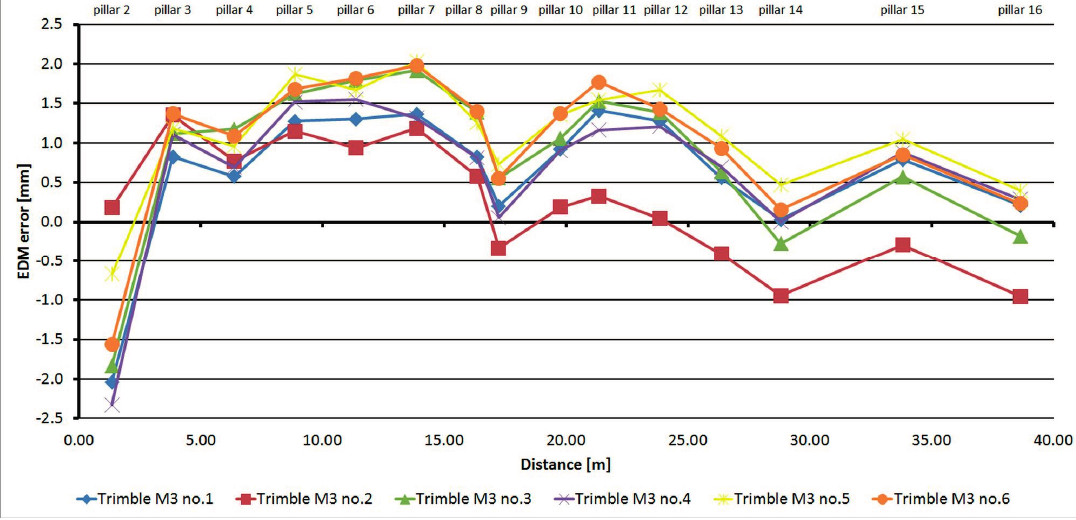
Figure 25. Comparison of absolute errors of six Trimble M3